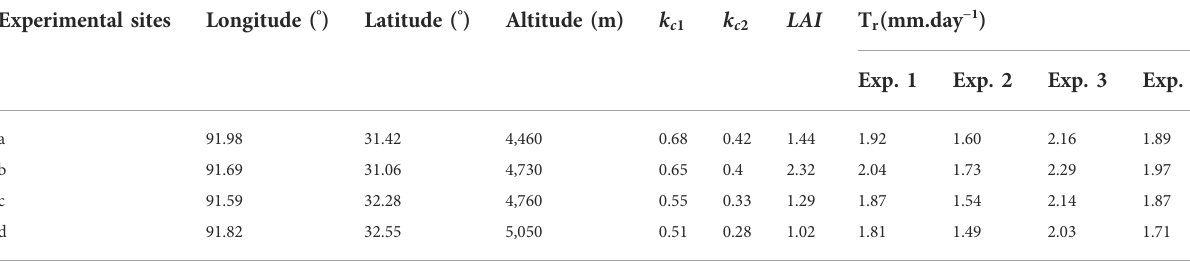
TABLE 1 The longitude, latitude, and altitude of the experimental locations; the mean crop coef fi cients ( k c1 ) during the re-greening stage and the mean crop coef fi cients (( k c2 ) during the wilting stage; the mean leaf area index (LAI) of the alpine meadows at different phenological stages, was obtained from the “ National Tibetan Plateau Scienti fi cData Center ” (http://data.tpdc.lyac.cn) (Zhao and Zhang., 2021); mean plant transpiration rate ( T r ) for Exp. 1, Exp. 2, Exp. 3 and Exp. 4. Experimental